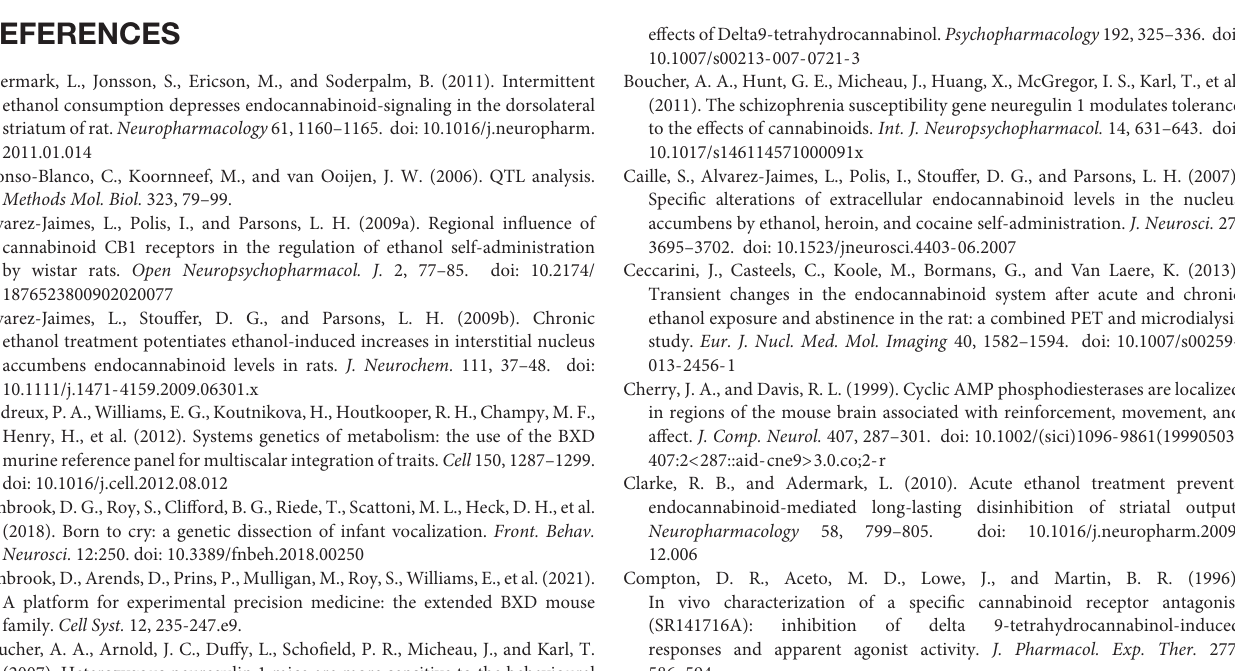
Supplementary Figure 1 | Age distribution among BXD subjects. Box plot for each strain and sex is shown. Median indicated by horizontal line. Interquartile range (IQR, 25th to 75th percentiles) represented by box. Whiskers indicate maximum (75th percentile + 1.5 × IQR) and minimum (25th percentile + 1.5 × IQR) range. Black points indicate outliers. Ages of BXD subjects are superimposed on the box plot as orange points. Supplementary Figure 2 | Distribution of initial response traits among B6, D2, and their recombinant inbred BXD progeny. Strains are shown on the x -axis and the y -axis shows initial response to THC treatment (difference between baseline day 0 and day 1). Male and female responses for each trait are shown in the left and right columns, respectively. Supplementary Figure 3 | Associations between QTGs and signaling, brain region, addiction, and psychiatric disease terms from the GeneCup Resource. The center node (red) represents the QTG. Terms are shown as nodes (colored by group: blue for signaling terms, yellow for drug terms, purple for addiction terms, green for brain region terms, brown for stress terms, and orange for psychiatric terms) radiating around the center node. Edges represent literature associations from PubMed and the edge thickness increases as the number of associations increases. For Pde4d , association to the cannabinoid term is indirect (dashed line) and is linked to PDE4 activity and the edge (de Jong et al., 2015) connected to the psychiatric_GWAS term is for an association ( p = 5E-8) between variants in the human gene (rs159497) and forced expiratory volume in 1 s (occupational environmental exposures